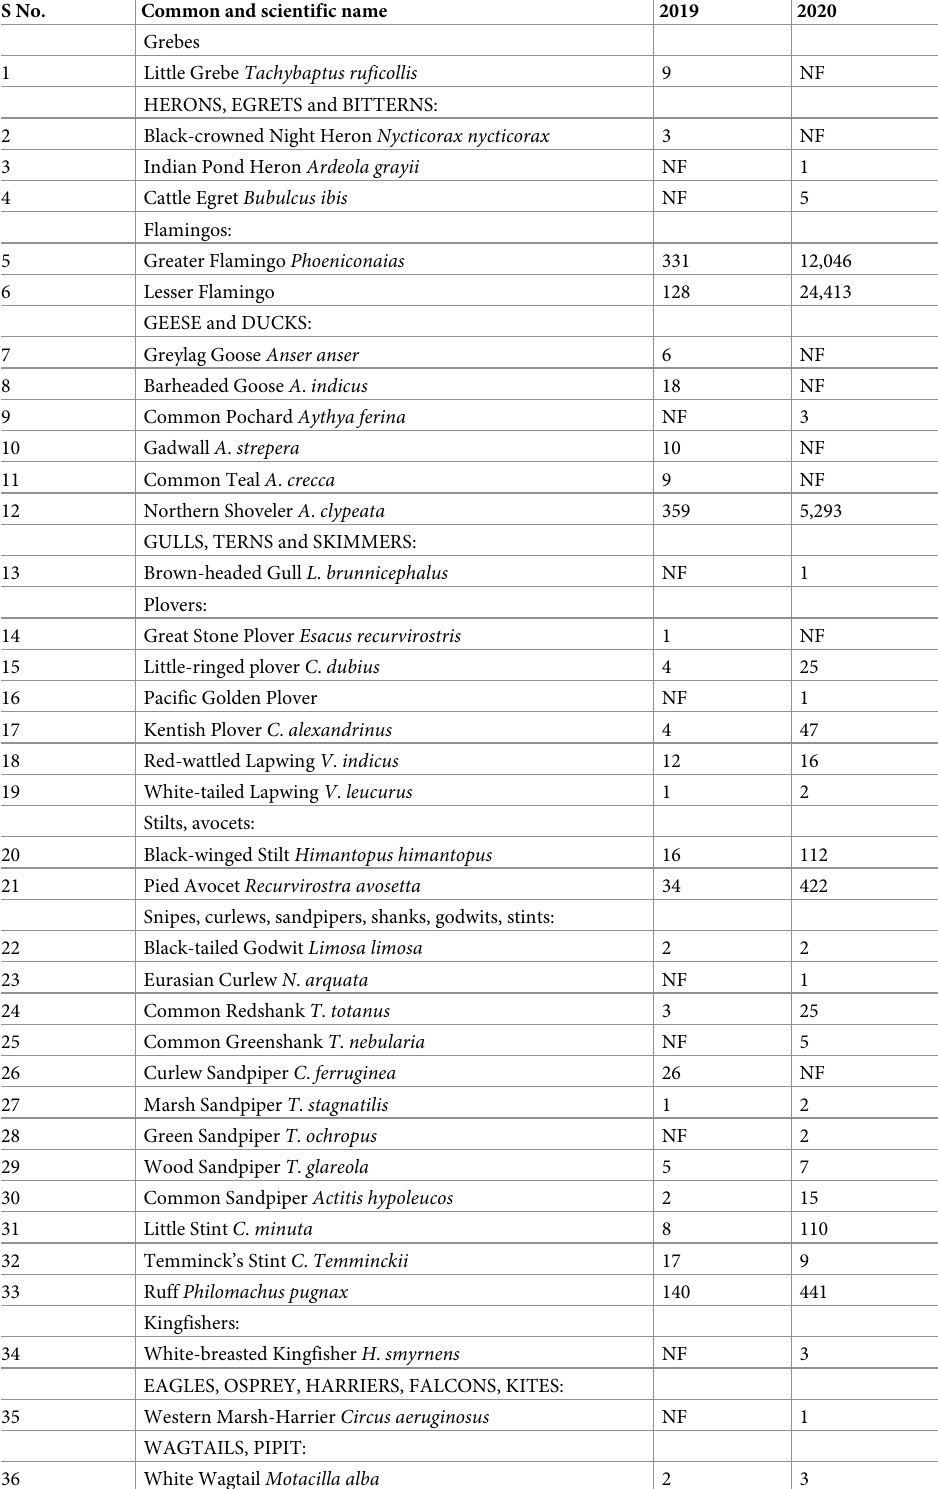
Table 1. Waterbirds counts and